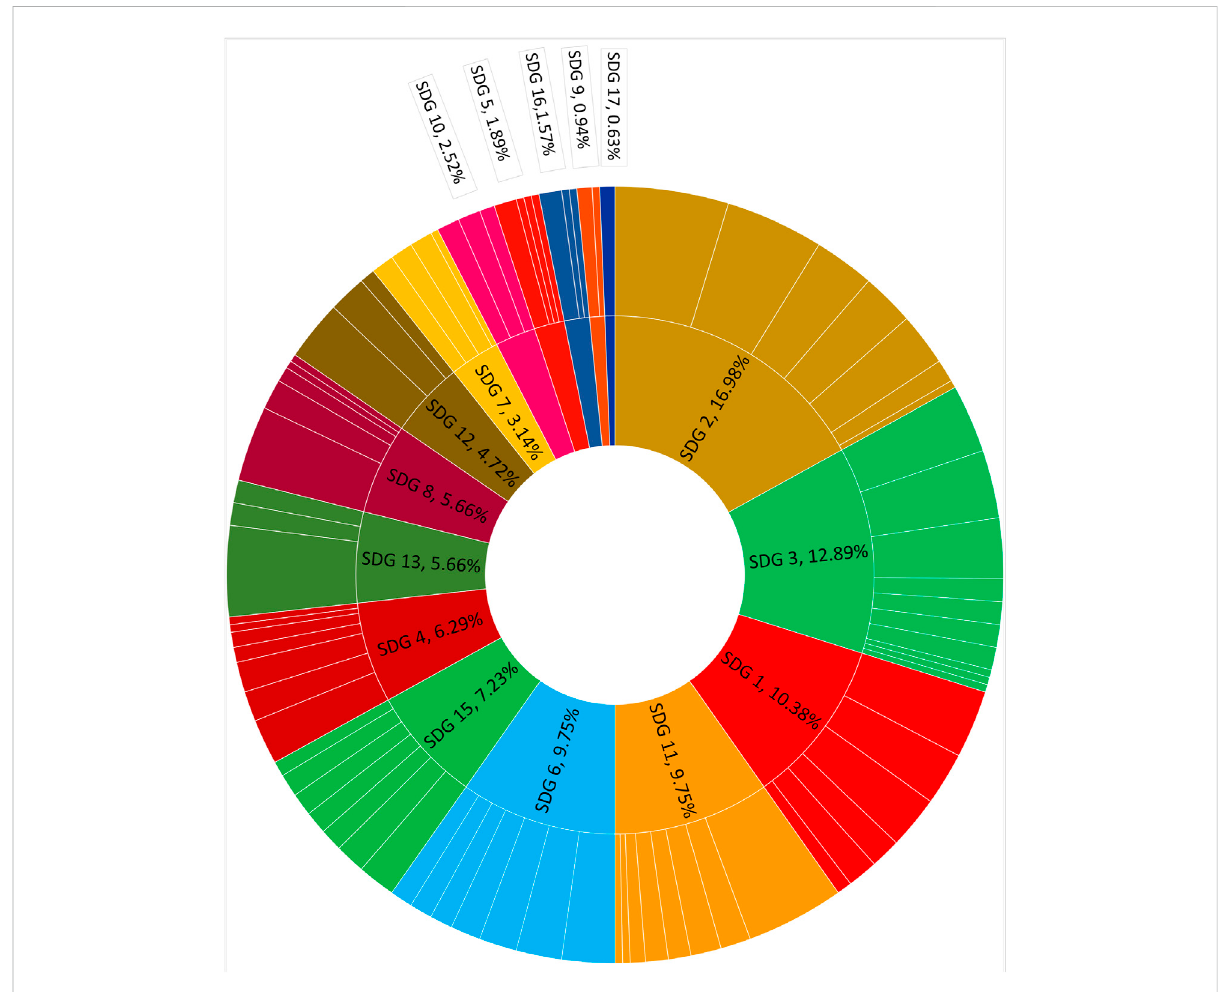
FIGURE 4 Proportion of indicator assignment to 2030 Agenda ‘ s SDGs (inside circumference) and targets (outside